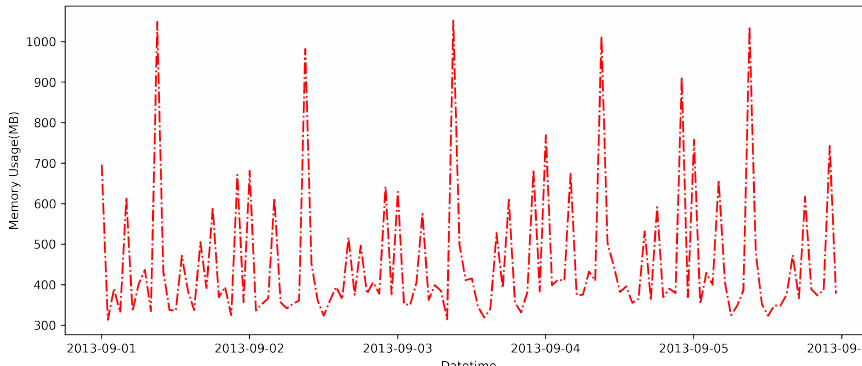
Figure 6. Behaviour of actual memory